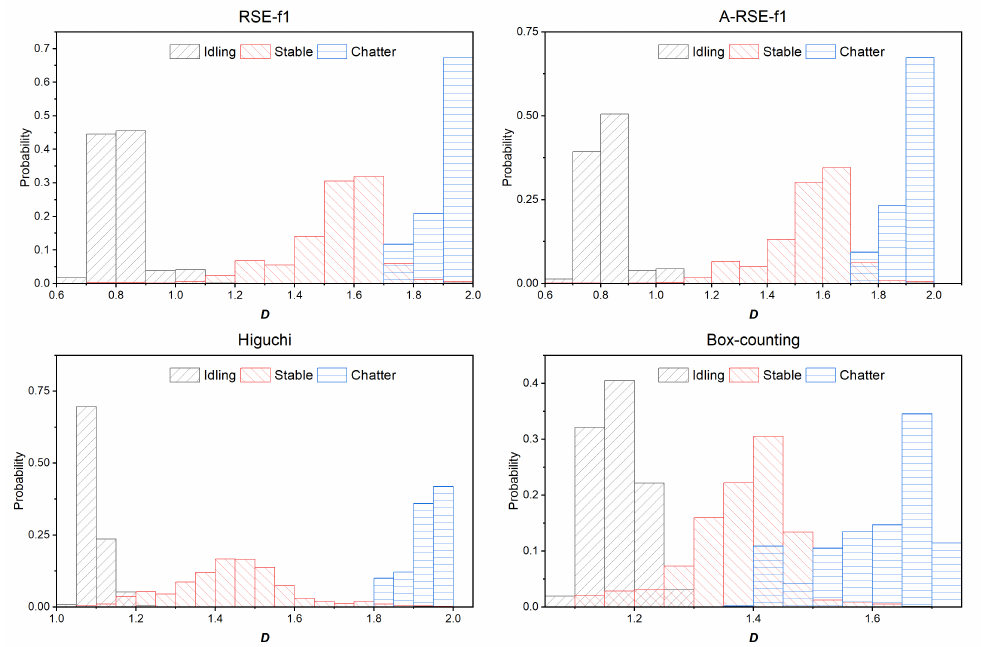
Figure 11. Histogram of D values distribution of 40 signals at different statuses calculated by RSE-f1, A-RSE-f1, Higuchi, and BC